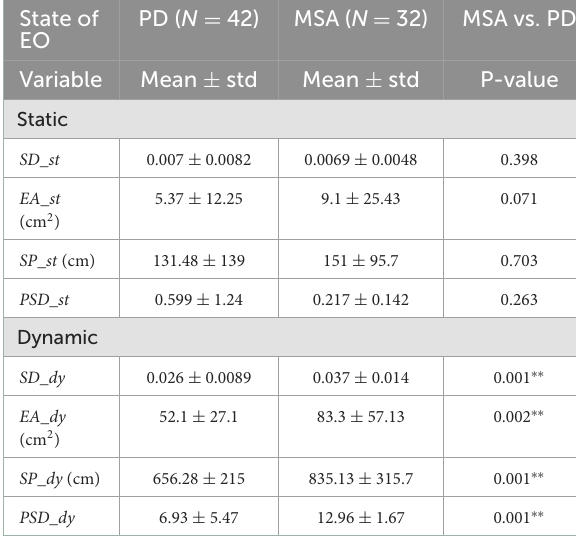
TABLE 2 Variables used in the analysis of the COP displacement. Variable